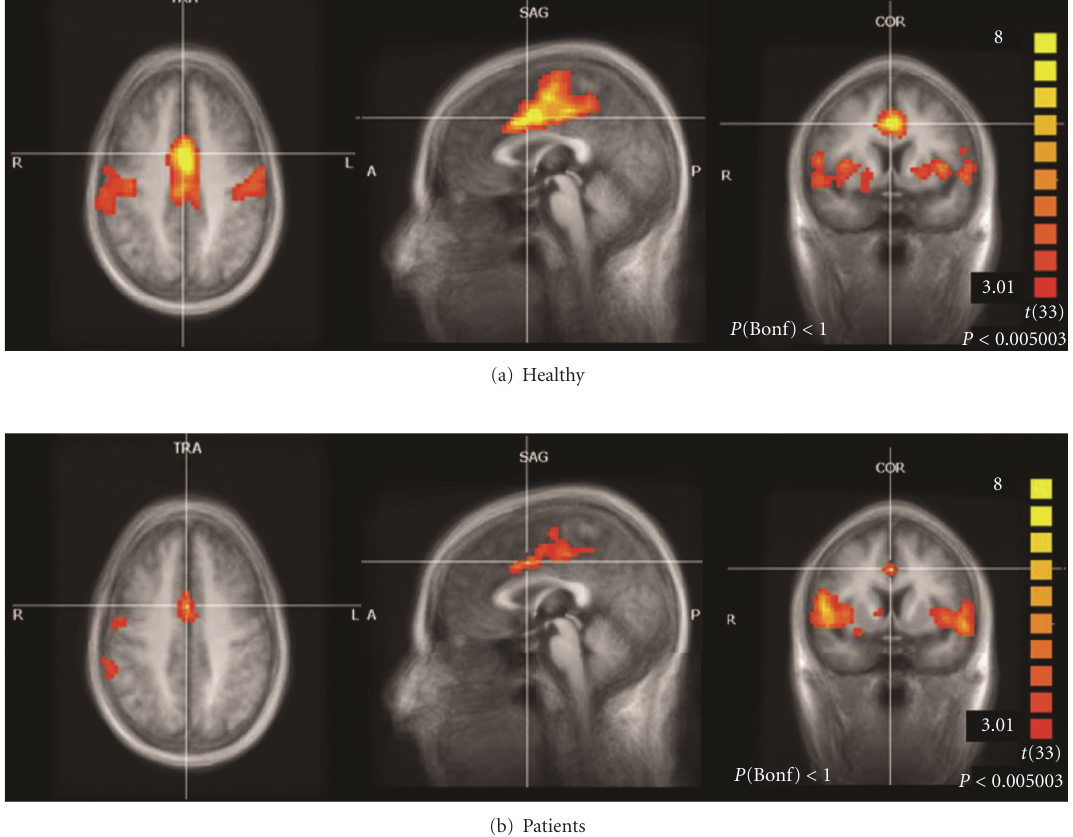
Figure 1: Sensorimotor network (SMN) in the healthy controls (a) and ALS patients (b) groups that Tedeschi et al. [28] examined by RS-fMRI (independent component analysis, ICA). The amount of coherent RS-fMRI fluctuations within this network appeared strongly reduced in the ALS